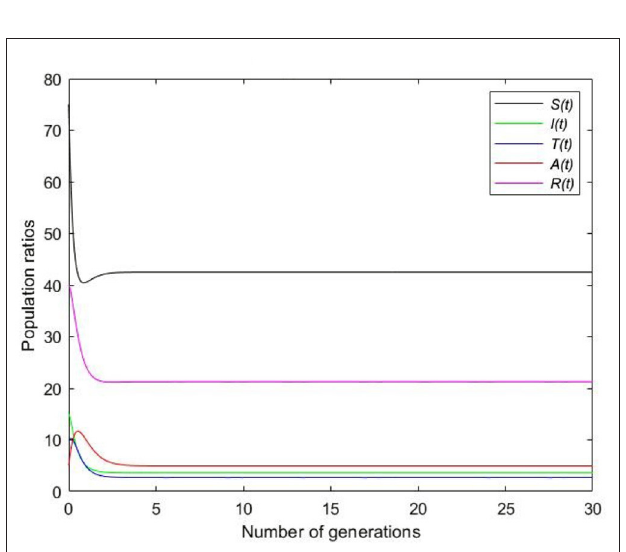
FIGURE 4 | Simulation with time dependence for disease-free equilibrium.